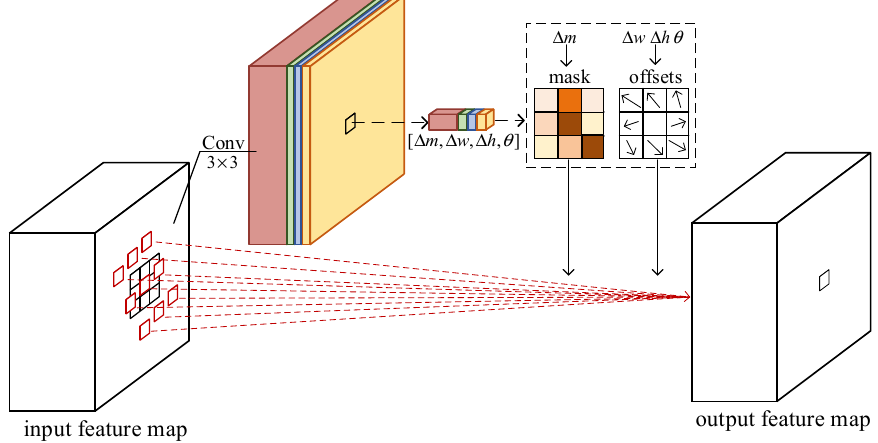
Figure 3. Illustration of the 3 3 × RIRConv.